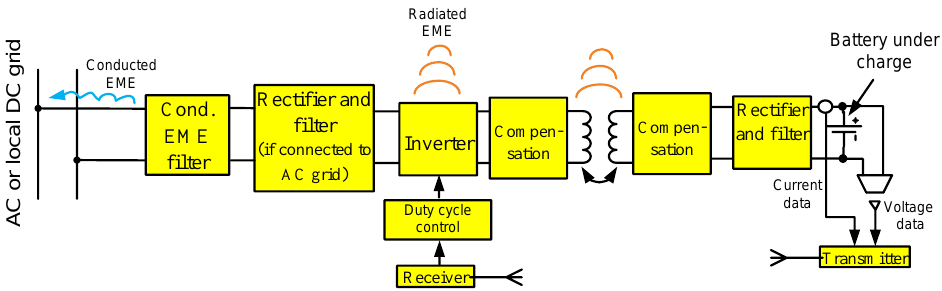
Figure 1. Simplified block diagram of the inductive-resonant WPT system connected to a grid irradiating EME.